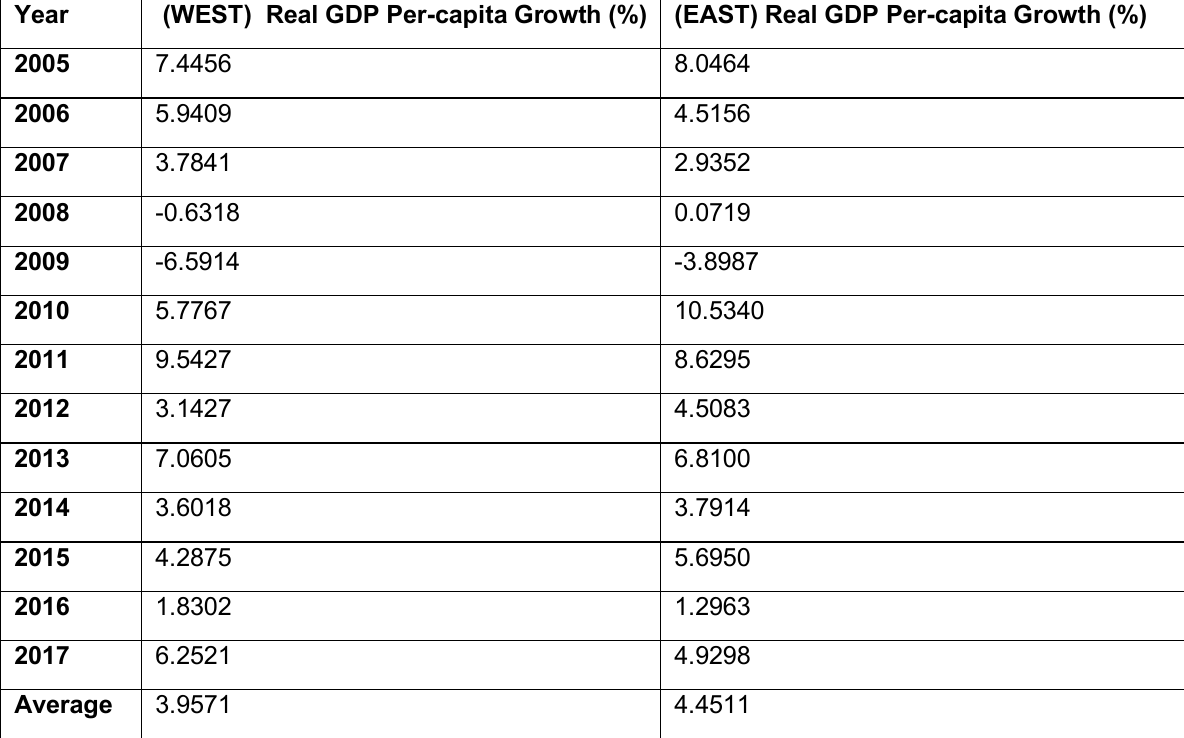
Table 10: West-East Real GDP Per-capita Growth